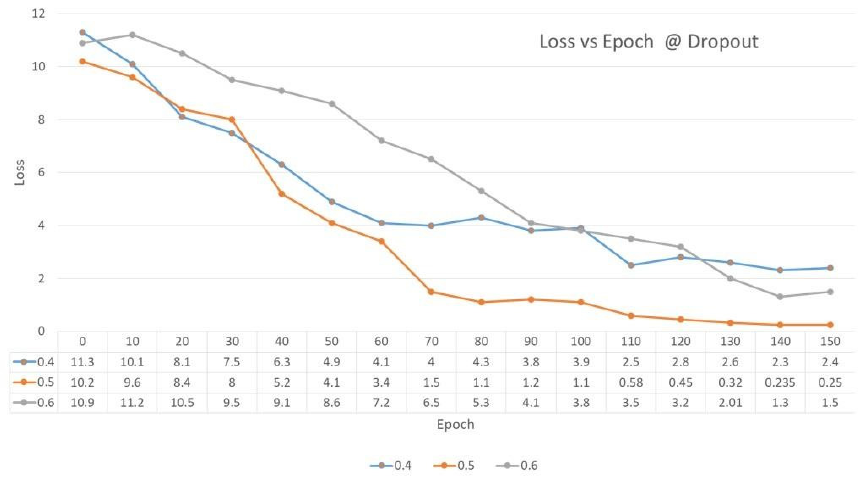
Figure 11. Comparison of Loss vs. Epoch @ Dropout.